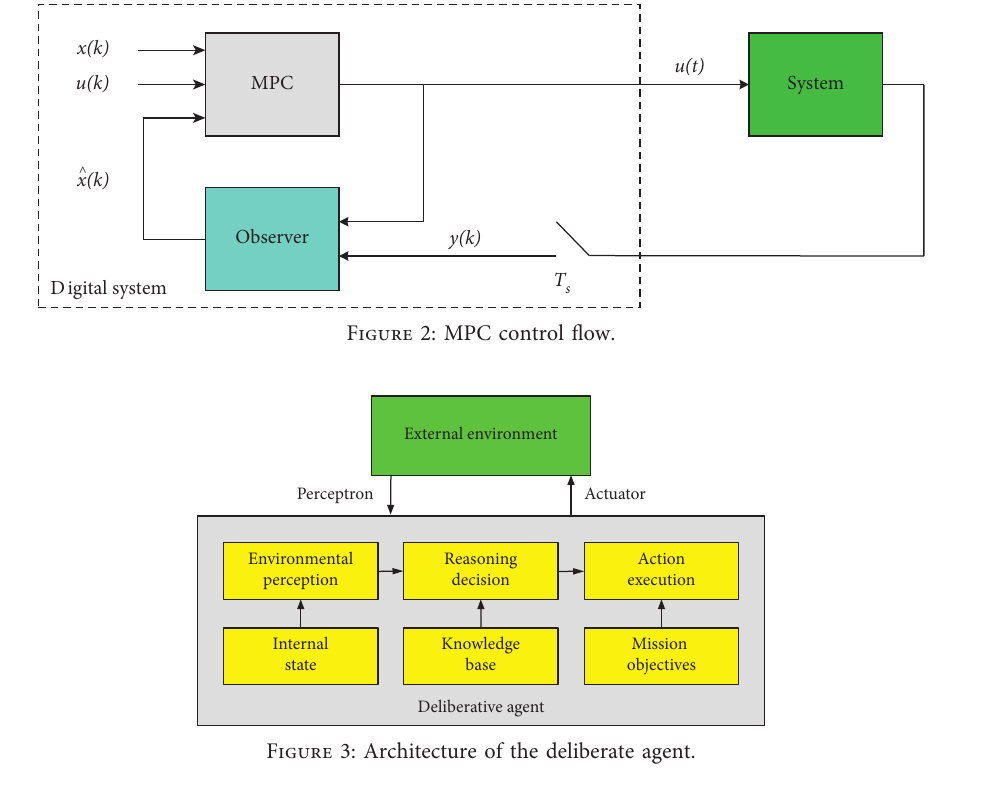
Figure 3: Architecture of the deliberate